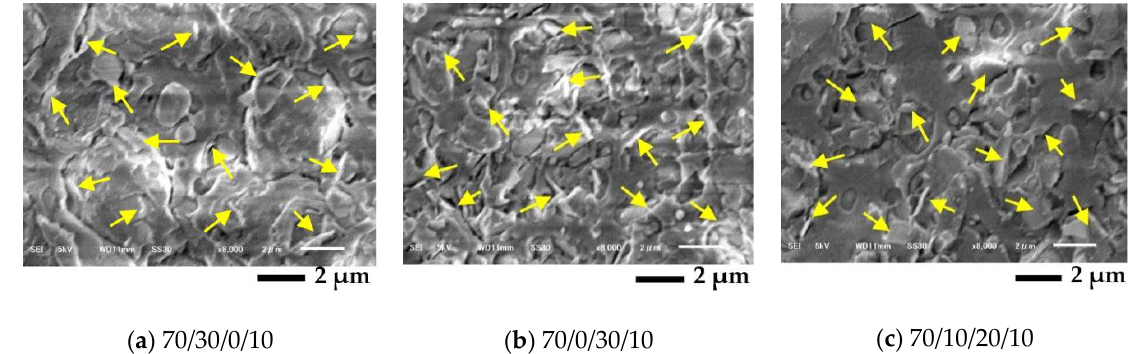
Figure 7. SEM images from cryogenic fractured surface of PLA/PBAT/PBS/nano talc: ( a ) 70/30/0/10; ( b ) 70/0/30/10; ( c ) 70/10/20/10.